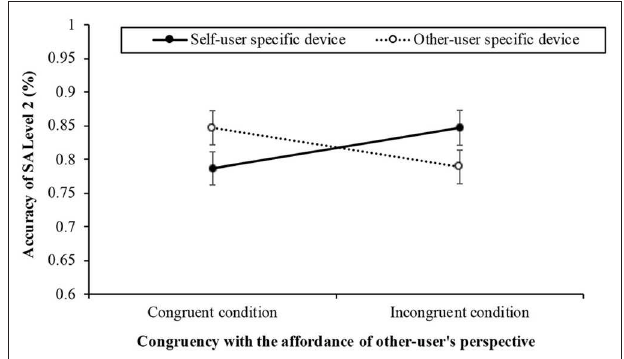
FIGURE 5 | The results of accuracy ( ± SE ) for answering the situation awareness (SA) Level 2 as the congruency with between the affordance of the other user’s perspective and the word (2: congruent, incongruent) and the primary user-specific devices (2: self, other) in Experiment